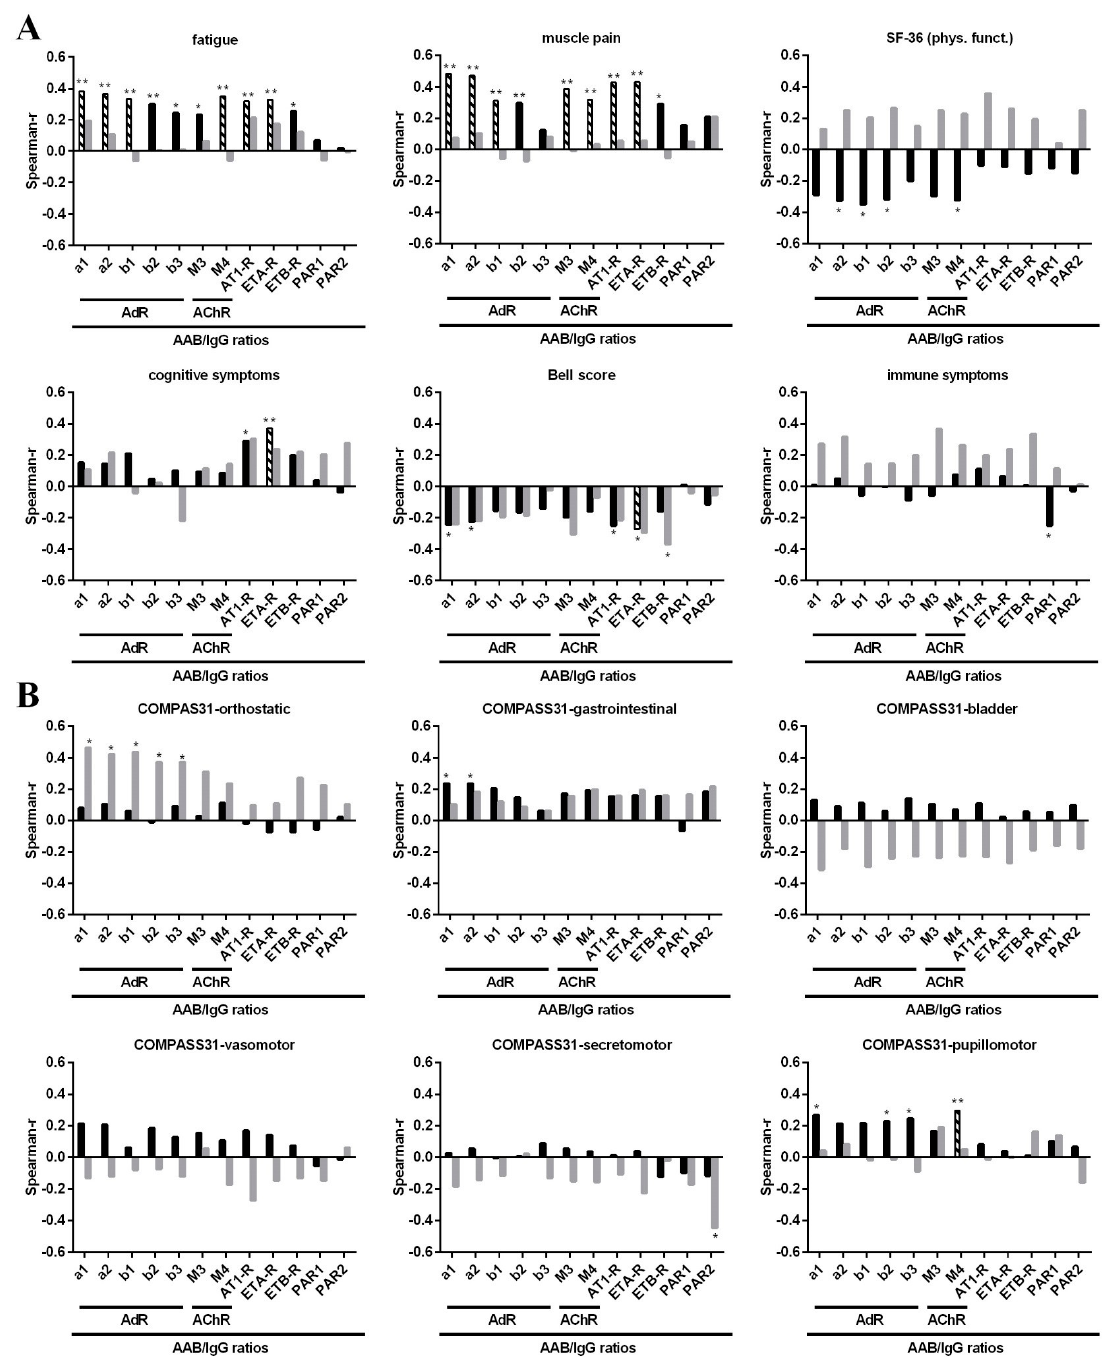
Figure 1. Correlations between symptom severity and AAB/IgG ratios. Correlation analysis of AAB/IgG ratios with the severity of ( A ) fatigue, muscle pain, cognitive and immune symptom scores, physical functioning (SF-36) and Bell disability score and ( B ) with COMPASS 31 subdomains. Spearman correlation coefficients (r) are shown for patients with infection-triggered onset (black bars) and patients without infection-triggered onset (grey bars). Significant correlations prior to BH-correction are marked with asterisks (* p < 0.05, ** p < 0.01), correlations that remained significant after BH-correction are indicated by black-and-white striped